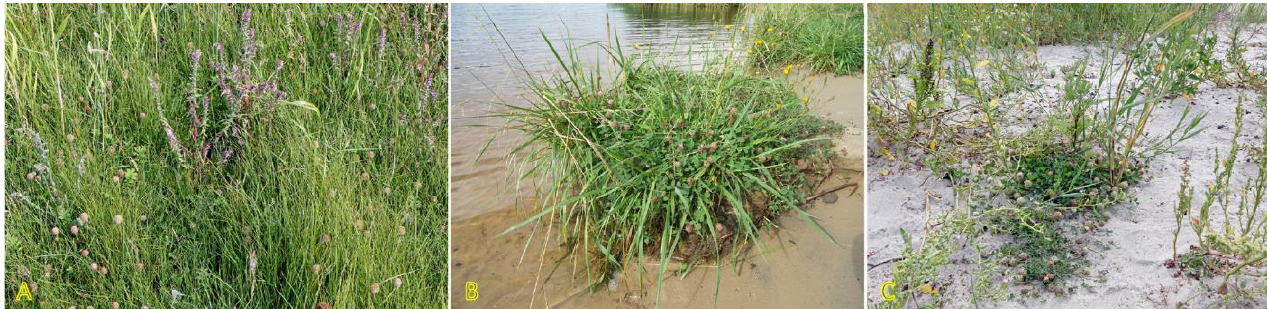
Figure 4. Trifolium fragiferum plants on a wet coastal meadow together with Odonites vulgaris , Poten- tilla anserina, etc., on the island of Kihnu, Estonia ( A ), on the shore of river Buļļupe, Buļļusala, Rīga, Latvia ( B ), and on the sandy beach in Varbla, Estonia ( C